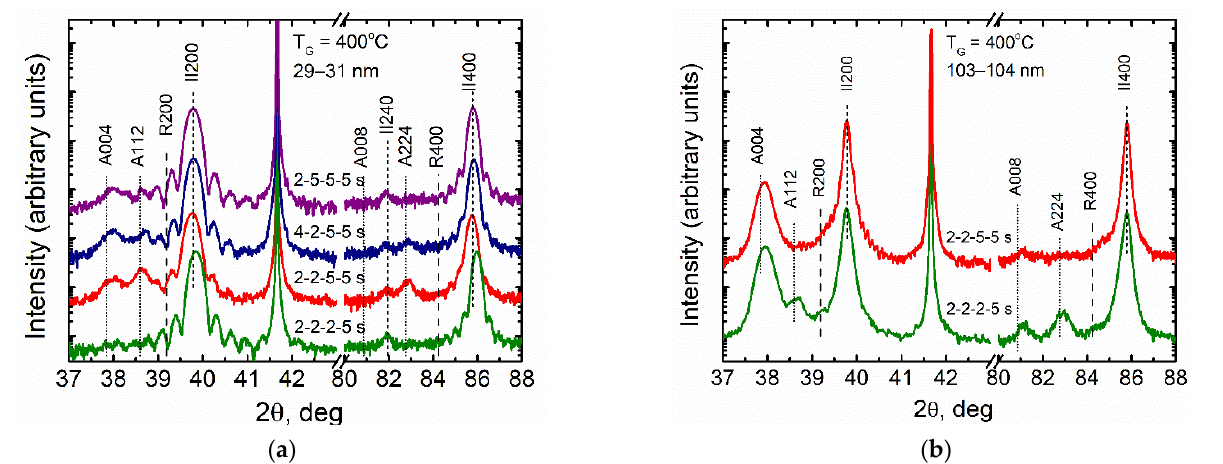
Figure 8. HRXRD patterns of ( a ) 29–31.nm and ( b ) 103–104-nm thick TiO 2 films grown on c-sapphire at 400 °C using different ALD cycle time parameters and shown with their respective diffraction patterns. Miller indices of anatase (A), rutile (R), TiO 2 -II (II), and sapphire (S) are shown with diffraction patterns. Vertical lines mark the database positions of anatase (PDF 84-1286), rutile (PDF 78-2485), and TiO 2 -II (PDF 01-076-6065) reflections.